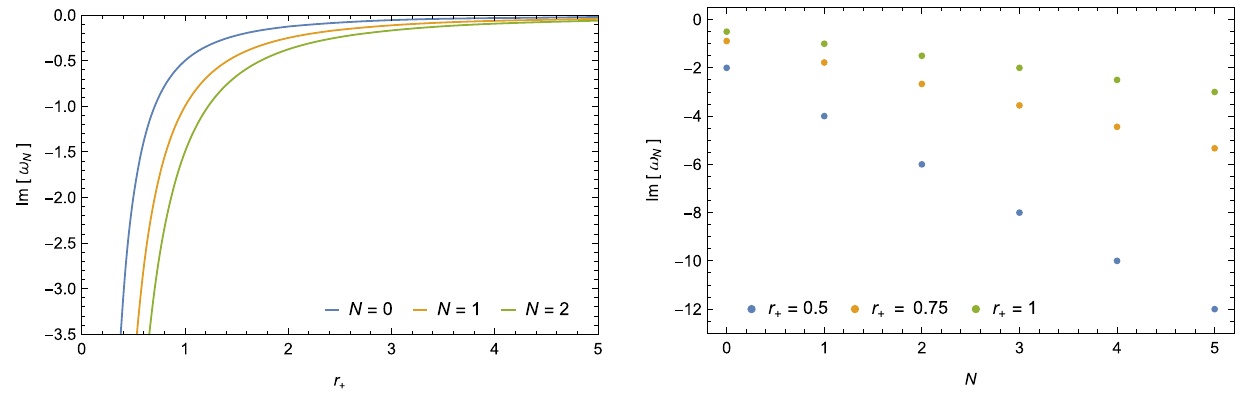
Fig. 9 (AdS) Case 1: a < 0. Massless scalar QBSs as a function of the exterior black hole event horizon (left) and principal quantum number